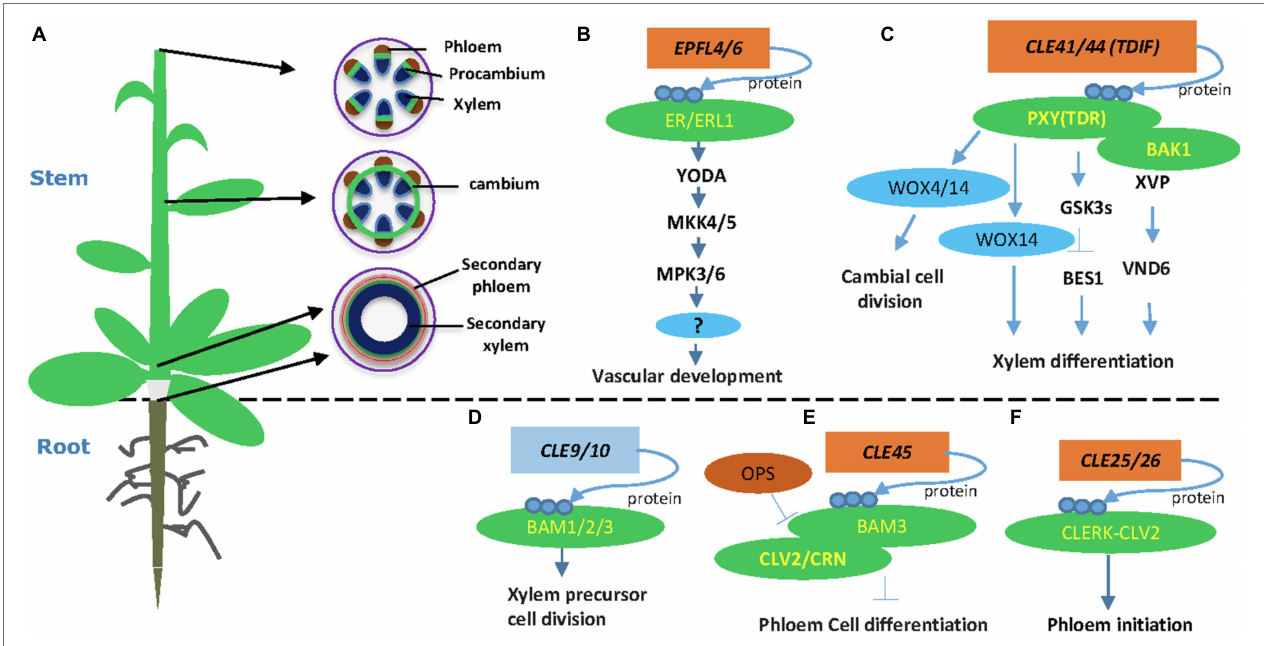
FIGURE 1 | Plant-specific CLE and Epidermal Patterning Factor-Like (EPFL) peptide signaling pathways in vascular development. (A) An Arabidopsis plant and different stages of vascular developmental in the stem. A young stem develops discrete vascular bundles that are comprised of phloem, xylem, and intervening procambium. In developing stems, cambial cells from vascular and interfascicular regions form a closed ring structure. Secondary growth produces secondary phloem and secondary xylem in both mature stem and hypocotyls. (B) The EPFL4 and EPFL6 peptides regulate stem vascular development in Arabidopsis . (C) CLE41/44 regulates vascular cambial cell division and xylem differentiation in the stem. (D) The CLE9/10 peptide regulates xylem formation. (E) The CLE45- BAM3 peptide inhibits root protophloem cell differentiation. (F) The CLE25 peptide promotes root protophloem cell differentiation. Arrows depict positive regulatory relationships and bars depict negative regulatory